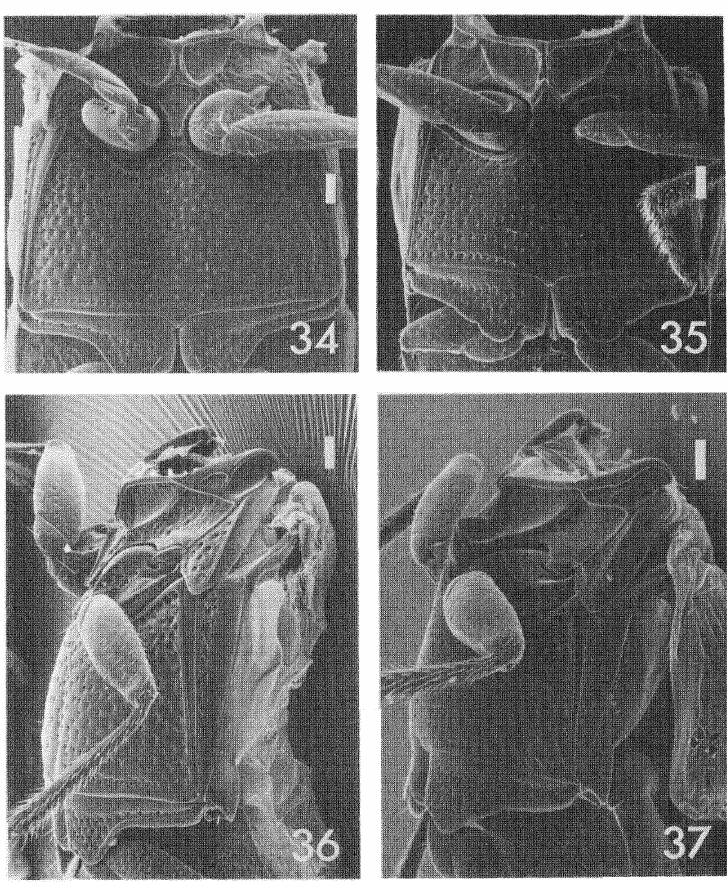
Figs. 34-37. Glypholoma spp., pterothorax. 34, 36. G. pustuliferum, ventral and oblique lateral views, respectively. 35, 37. G. rotundulum, ventral and oblique lateral views, respectively. Scale lines 0.1